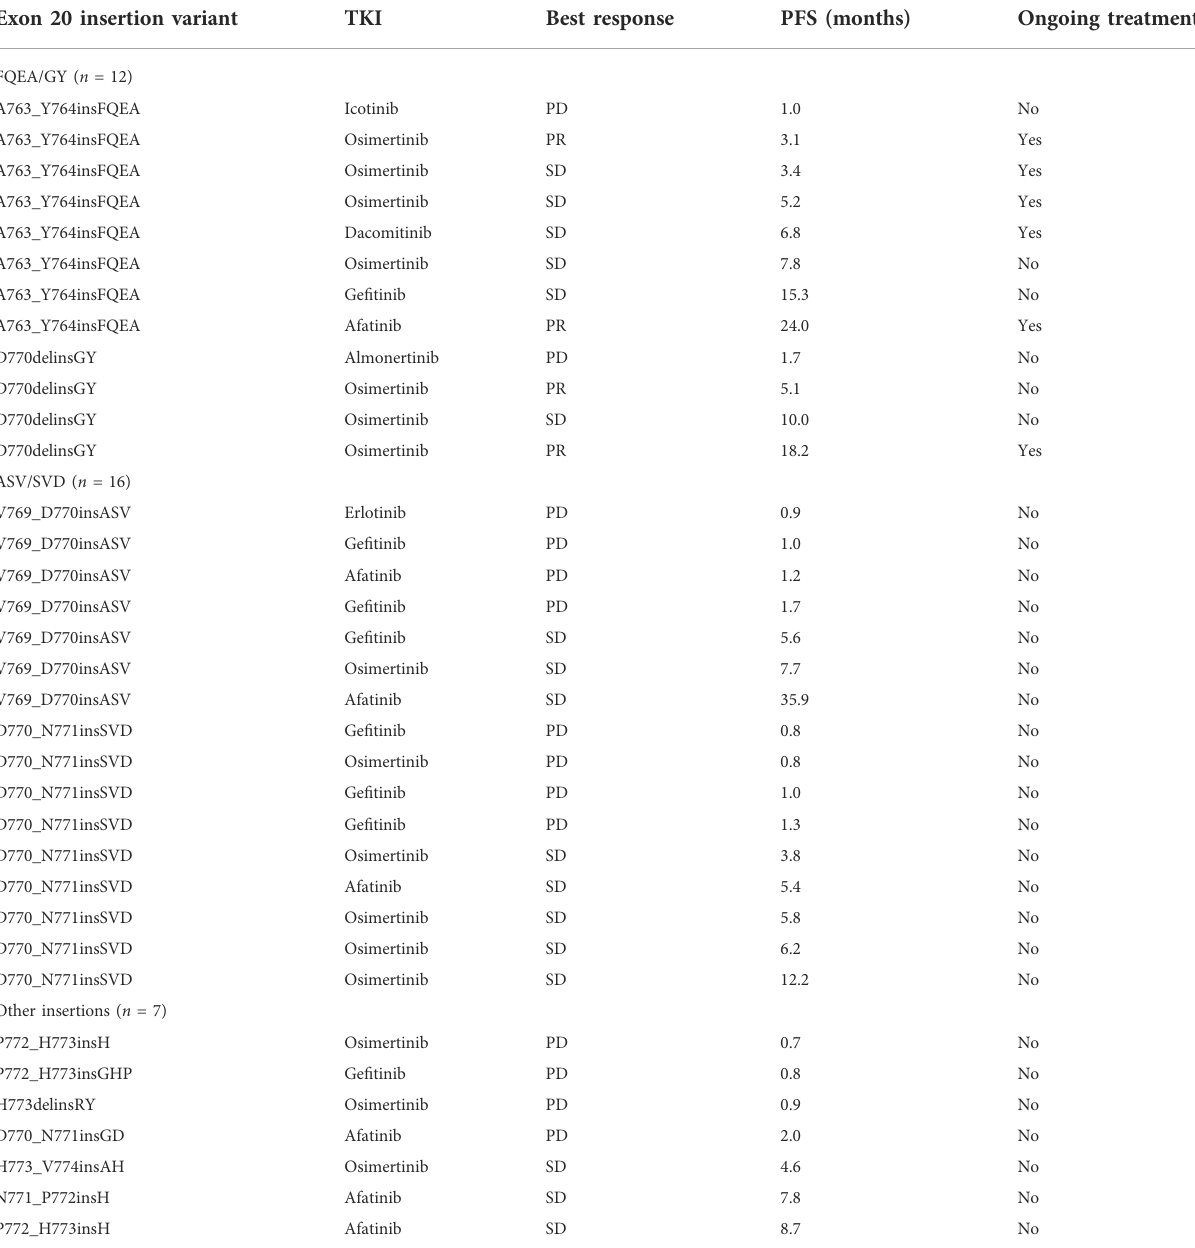
TABLE 2 First-line EGFR TKIs for NSCLC patients with diverse EGFR exon 20 insertion subtypes ( n = 35). Exon 20 insertion variant TKI Best response PFS